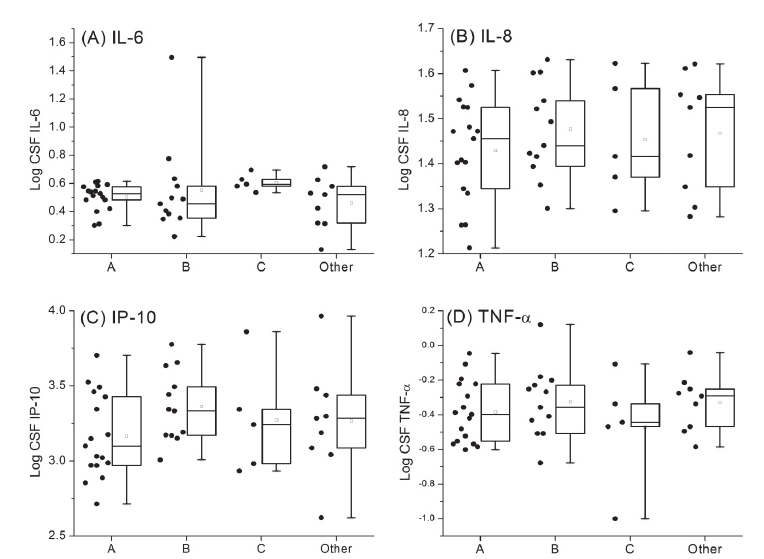
Supplemental Figure 3. Measured cytokine levels in CSF for (A) IL-6, (B) IL-8, (C) IP-10, and (D) TNF-α in participants of Hispanic ancestry. Data are shown for the major Native American/Asian hap- logroups A, B, and C found in persons of Hispanic ancestry. All minor haplogroups are combined into the “other”